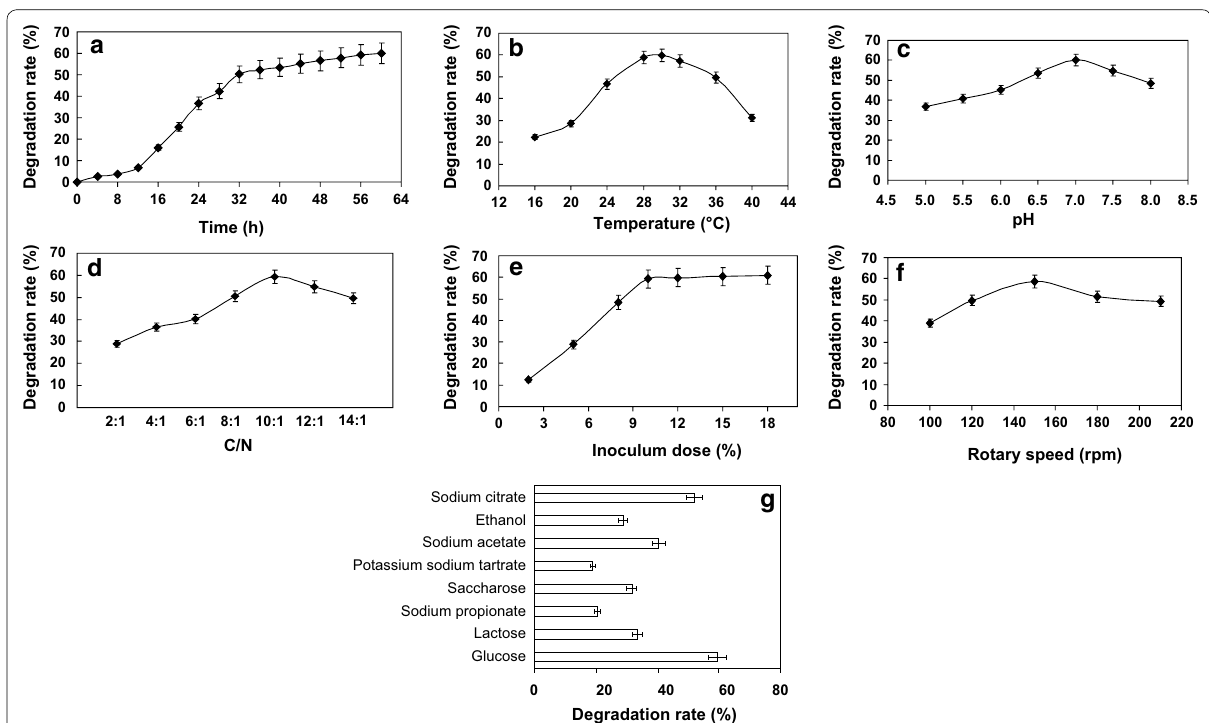
Fig. 5 Optimization of the conditions for NH 4 + ‑N degradation. The optimized conditions included incubation time ( a ), temperature ( b ), pH ( c ), C/N ratio ( d ), inoculum dose ( e ), rotary speed ( f ), and carbon source ( g ). The degradation tests were performed in triplicate, and the results were shown as mean standard deviation ± Table 3 Orthogonal design for NH -N degradation 4 +